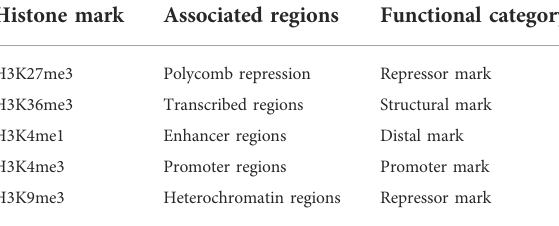
TABLE 1 Five core histone modi fi cation marks and their functional